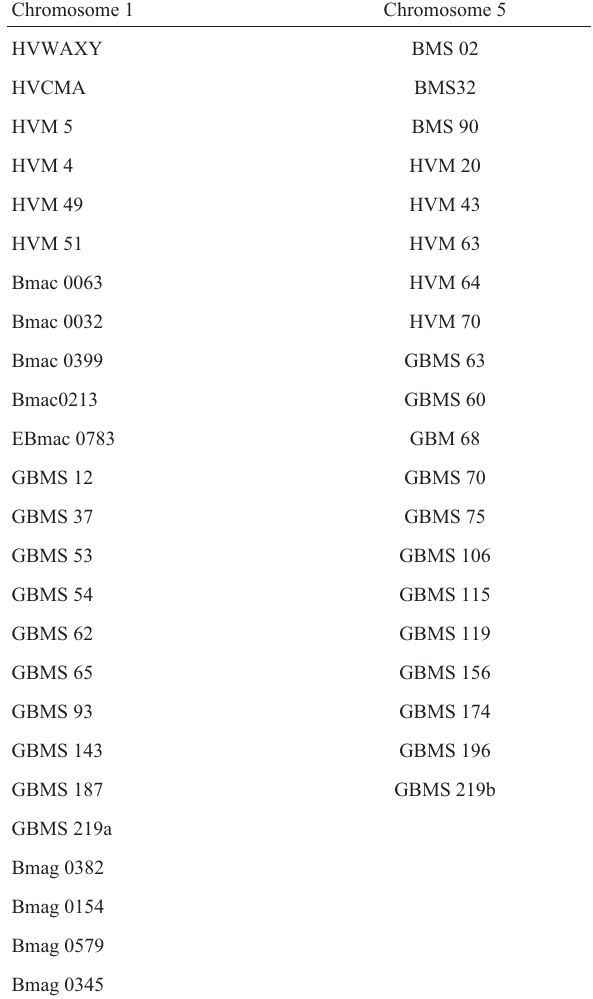
Table 1 - List of primers for chromosome 1 and 5 of barley used for find- ing SSR markers for spot blotch resistance.